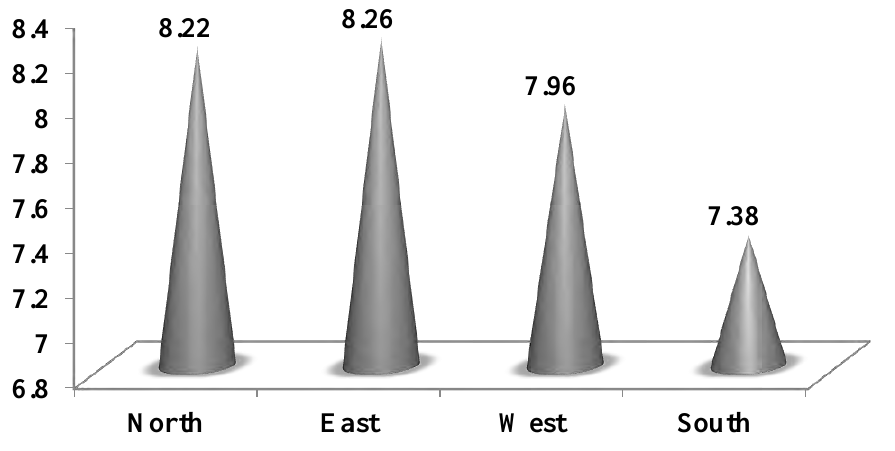
Figure 3. Graphical representation of mean scores with regard to North, East, West and South regions female baseball players on the sub-parameter Value Orientation Analysis of Variance (ANOVA) results among North, East, West and South regions female baseball players with regard